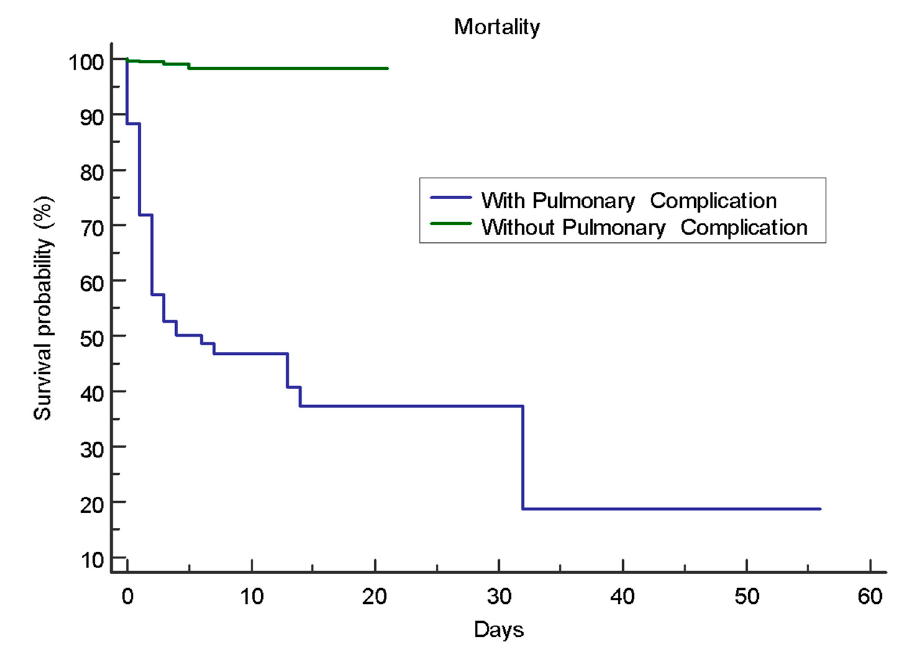
Figure 1. Kaplan–Meier survival curve.